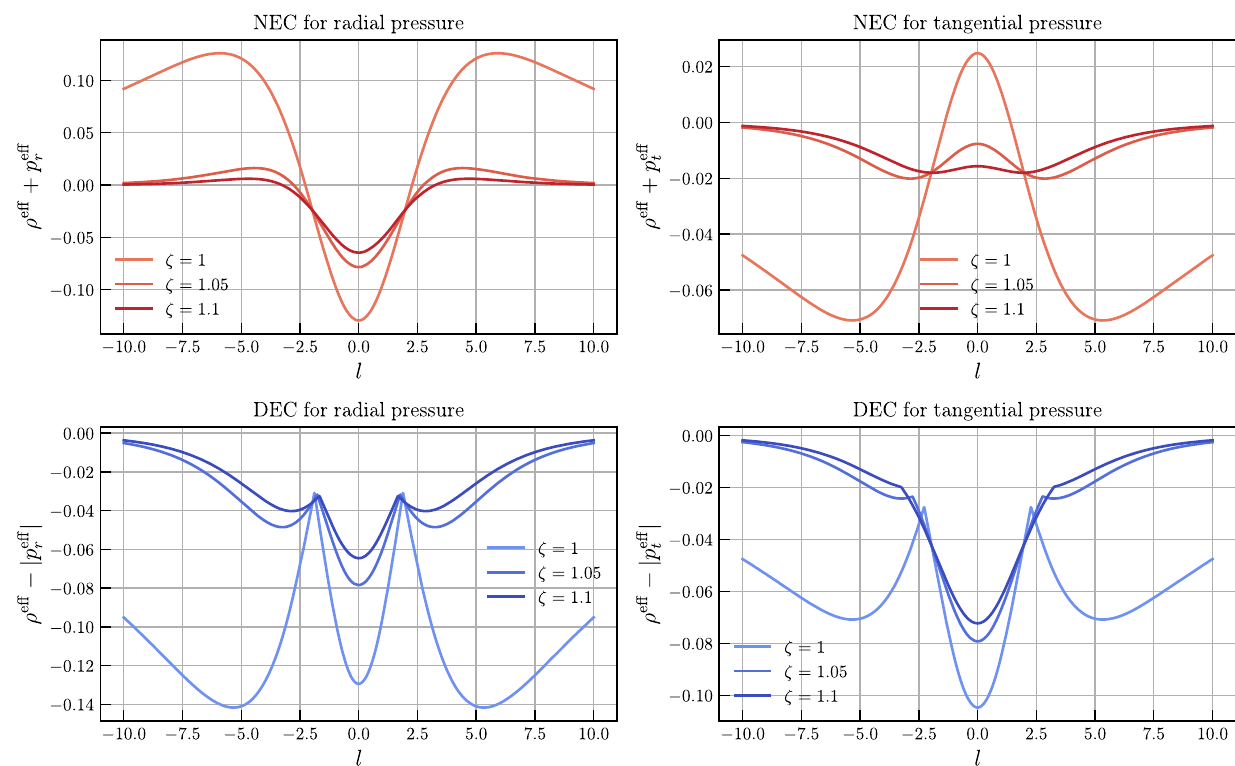
Fig. 1 Null and Dominant energy conditions for GEB wormhole. To plot the results, we have considered that wormhole throat is equal to b 0 = 5, and cosmological constant is set to by unity (for simplicity). Furthermore, m = 2 and α = 0 . 5, β = 0 .